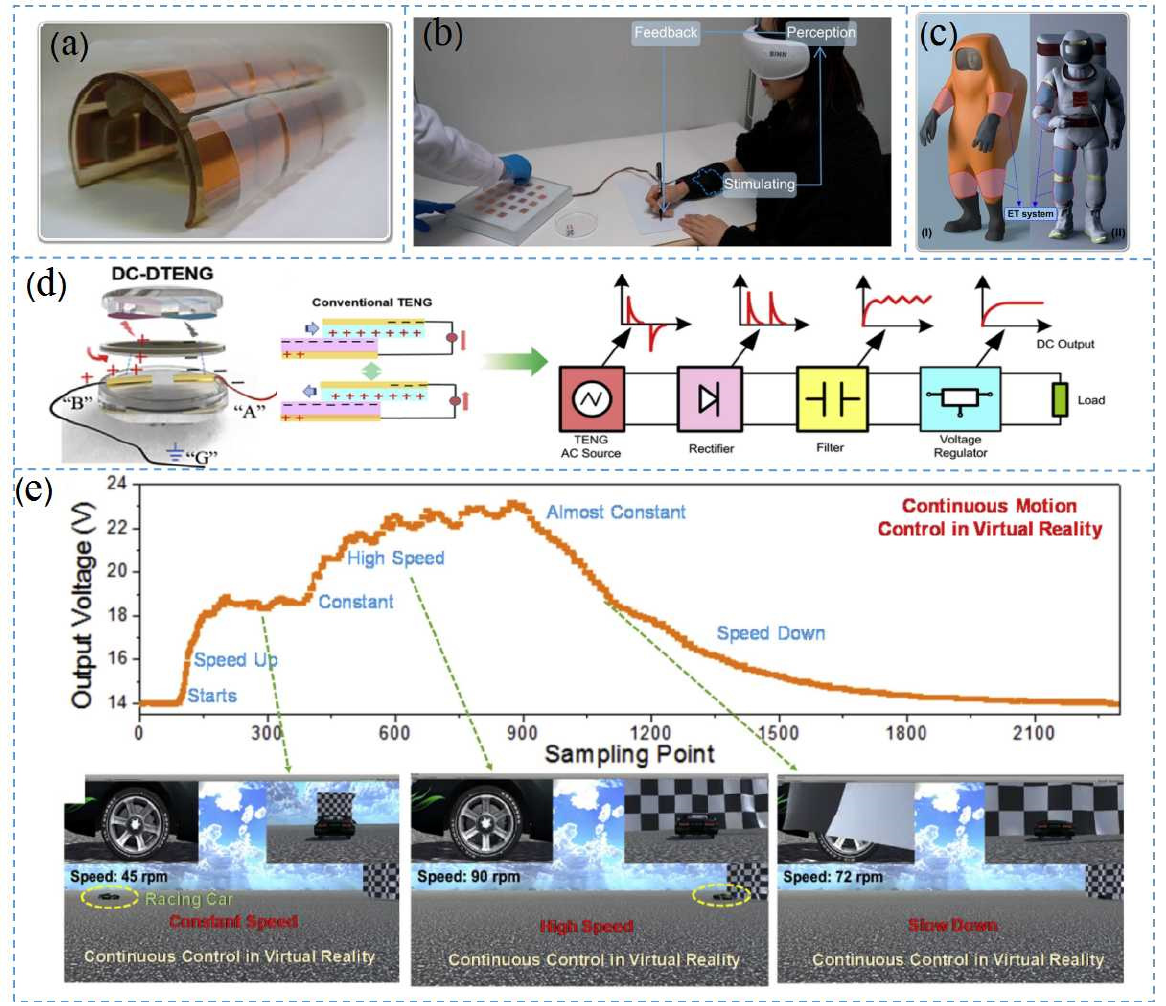
Figure 11. VR application of TENG: ( a ) unit structure of a self-powered, painless, and highly sensitive electro-tactile (ET) system based on TENG and spherical electrode arrays; ( b ) ET system applied to a dynamic braille display; ( c ) positive pressure suits and spacesuits equipped with ET systems, Reprinted with permission from ref. [39]. Copyright 2021 Science Advances; ( d ) DC-DTENG using an external electric device for DC output; and ( e ) DC-DTENG controlling the output voltage when the virtual vehicle performed at different speeds, Reprinted with permission from ref. [43].